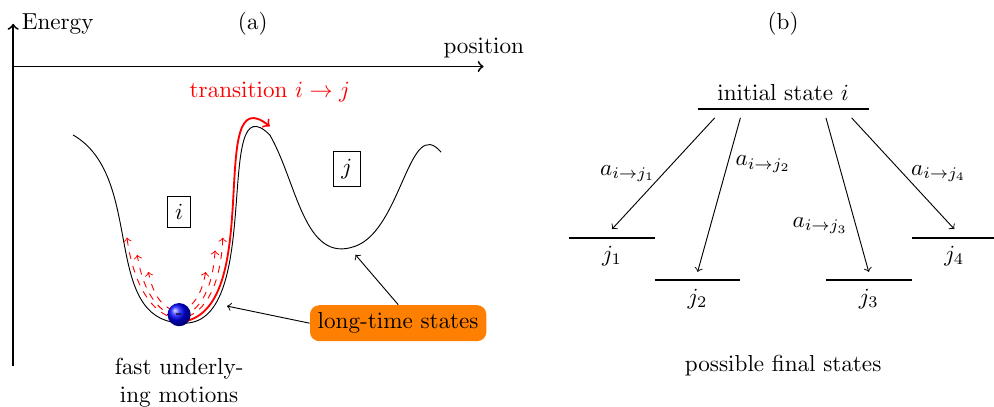
Figure 1. ( a ) Coarse-graining of the system dynamics and illustration of long-term system states; ( b ) transition from initial state i to final states j as employed in the kinetic Monte Carlo (kMC)